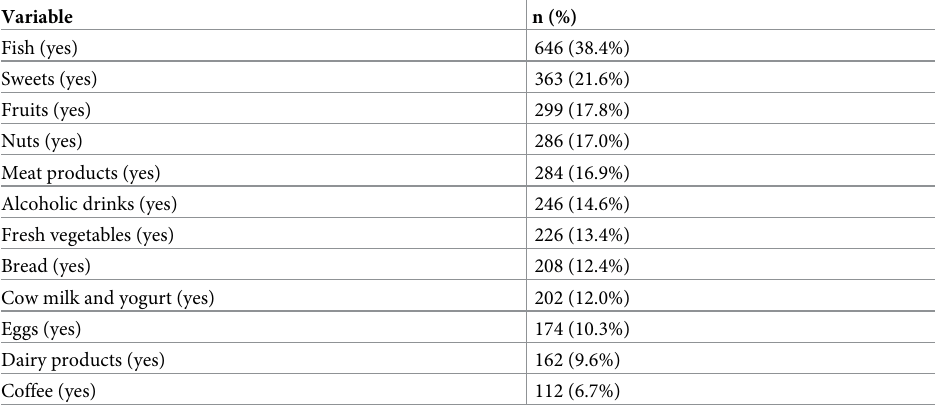
Table 3. Description of the food items that were consumed more during the lockdown compared to before